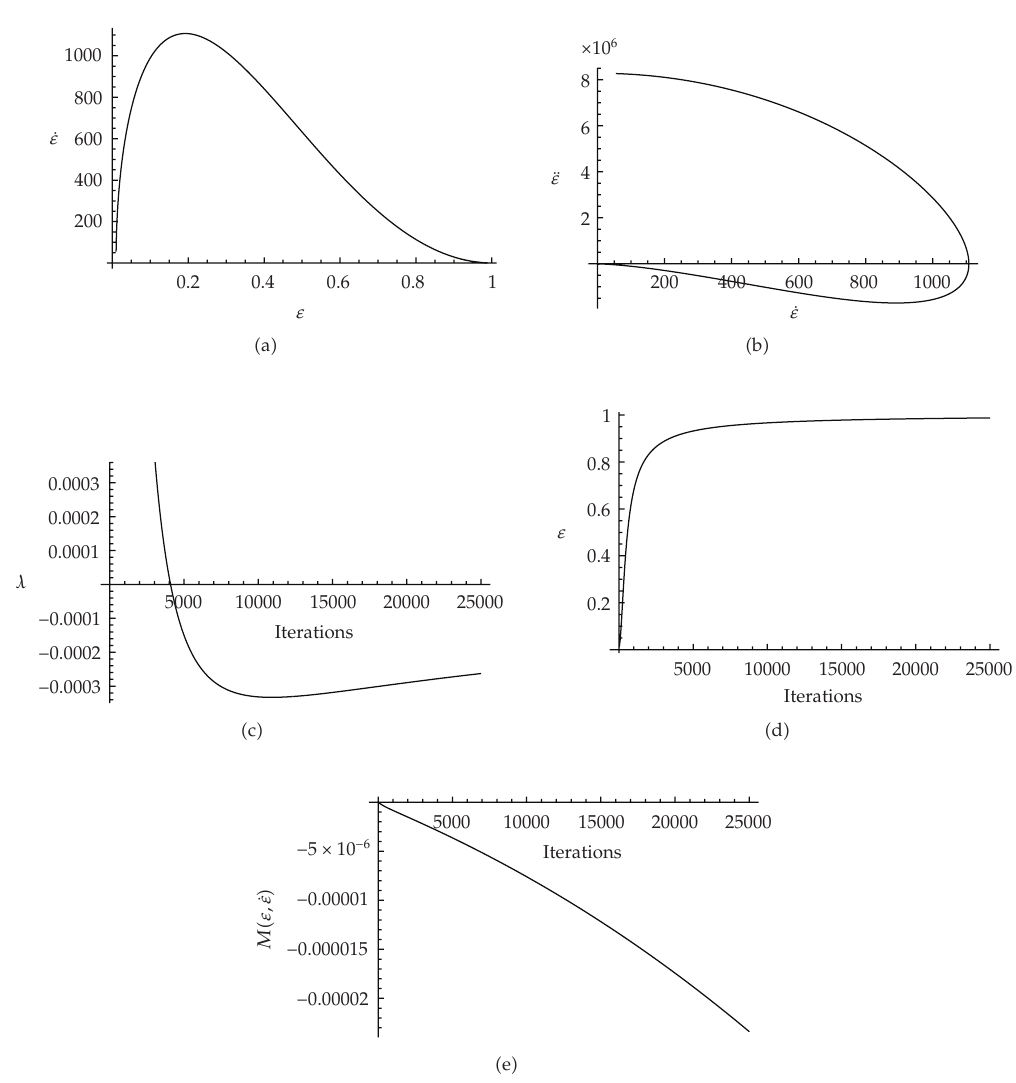
Figure 7: (cid:6) a (cid:7) and (cid:6) b (cid:7) An attractor without fluctuations (cid:6) cycles (cid:7) . (cid:6) a (cid:7) ε, ˙ ε graph and (cid:6) b (cid:7) ˙ ε, ¨ ε graph. (cid:6) c (cid:7) Lyapunov exponent and (cid:6) d (cid:7) ε itself, as functions of the (cid:6) universal (cid:7) time iterations. (cid:6) e (cid:7) The e ff ective mass steadily grows (cid:6) in absolute value (cid:7) as ε moves towards